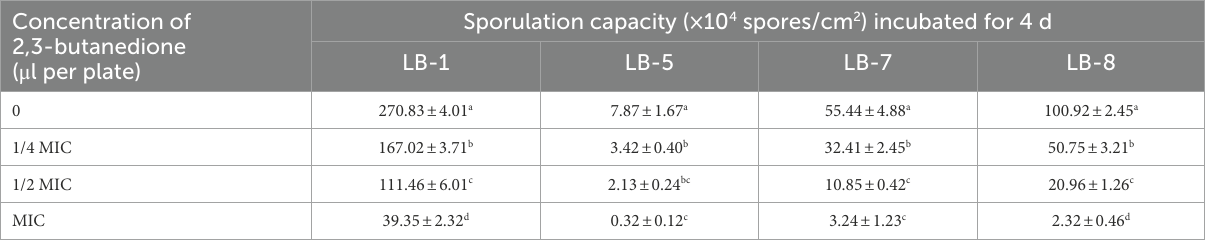
TABLE 3 Effects of 2,3-butanedione on the sporulation capacity. Concentration of